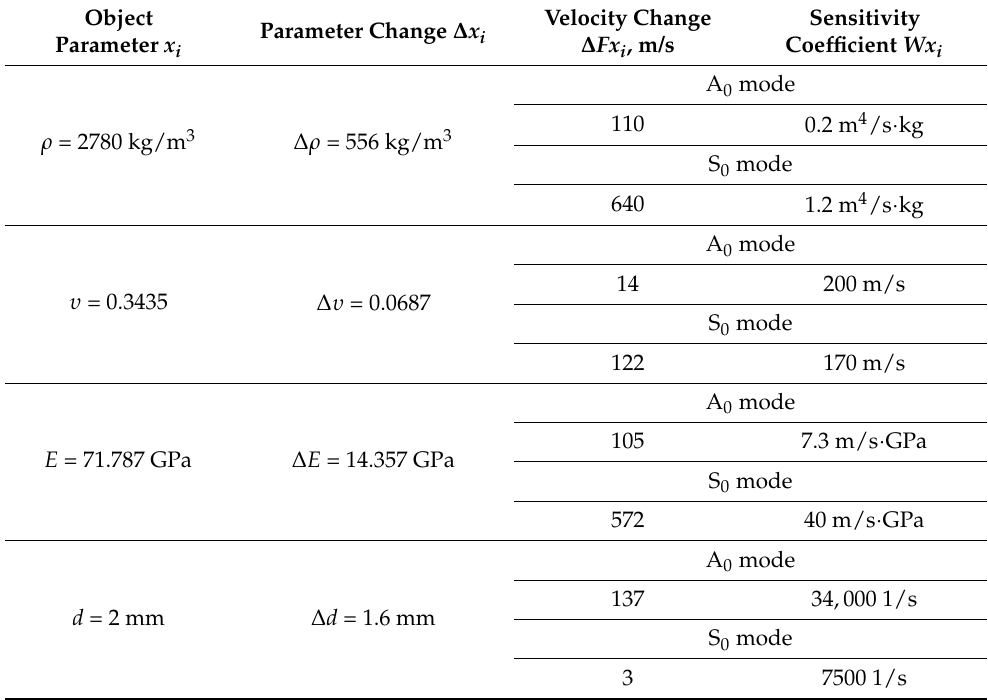
Table 4. Phase-velocity dependence on the material density, ρ ; Young’s modulus, E ; the Poisson’s ratio, υ ; and the plate thickness, d , for the A 0 and S 0